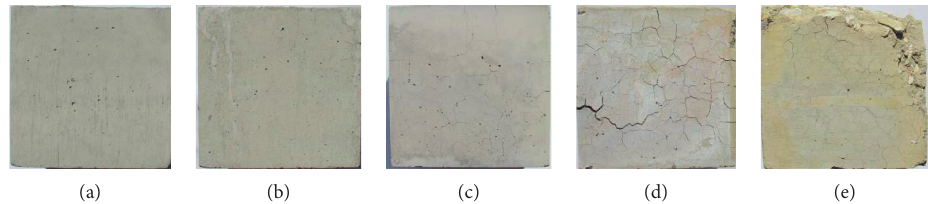
Figure 8: Typical pictures of the DSRR-60% specimen after elevated temperature. (a) 100 ° C. (b) 300 ° C. (c) 500 ° C. (d) 700 ° C. (e) 900 °